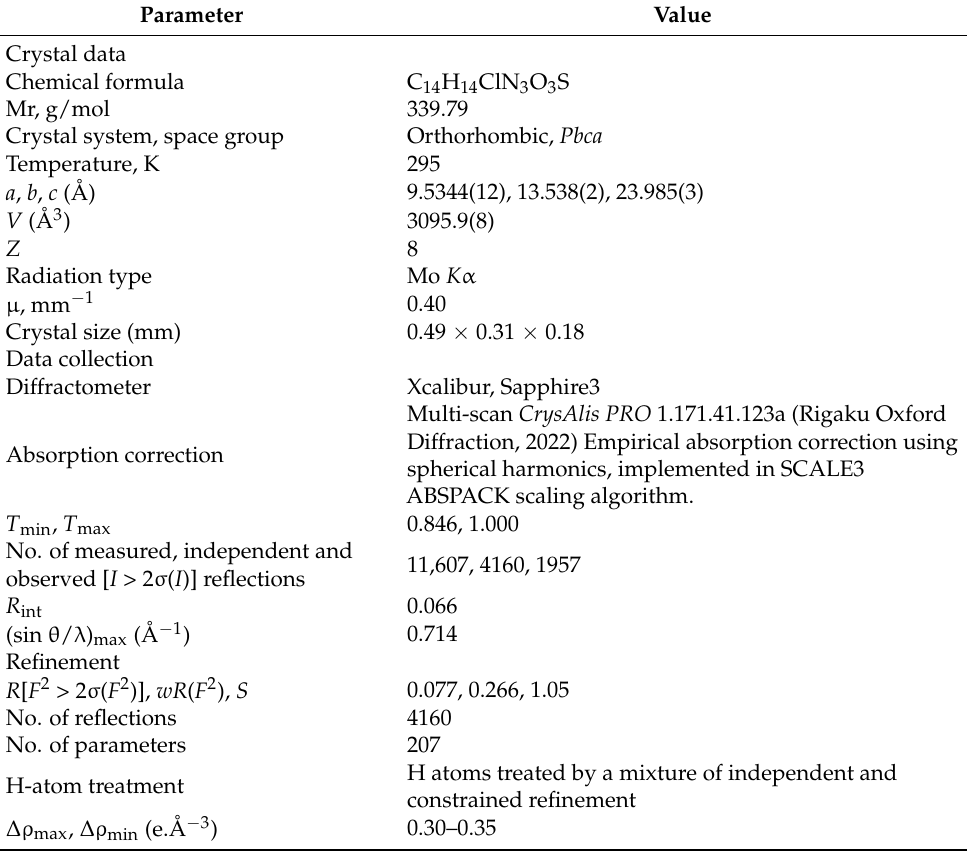
Table 5. Experimental details of the XRD